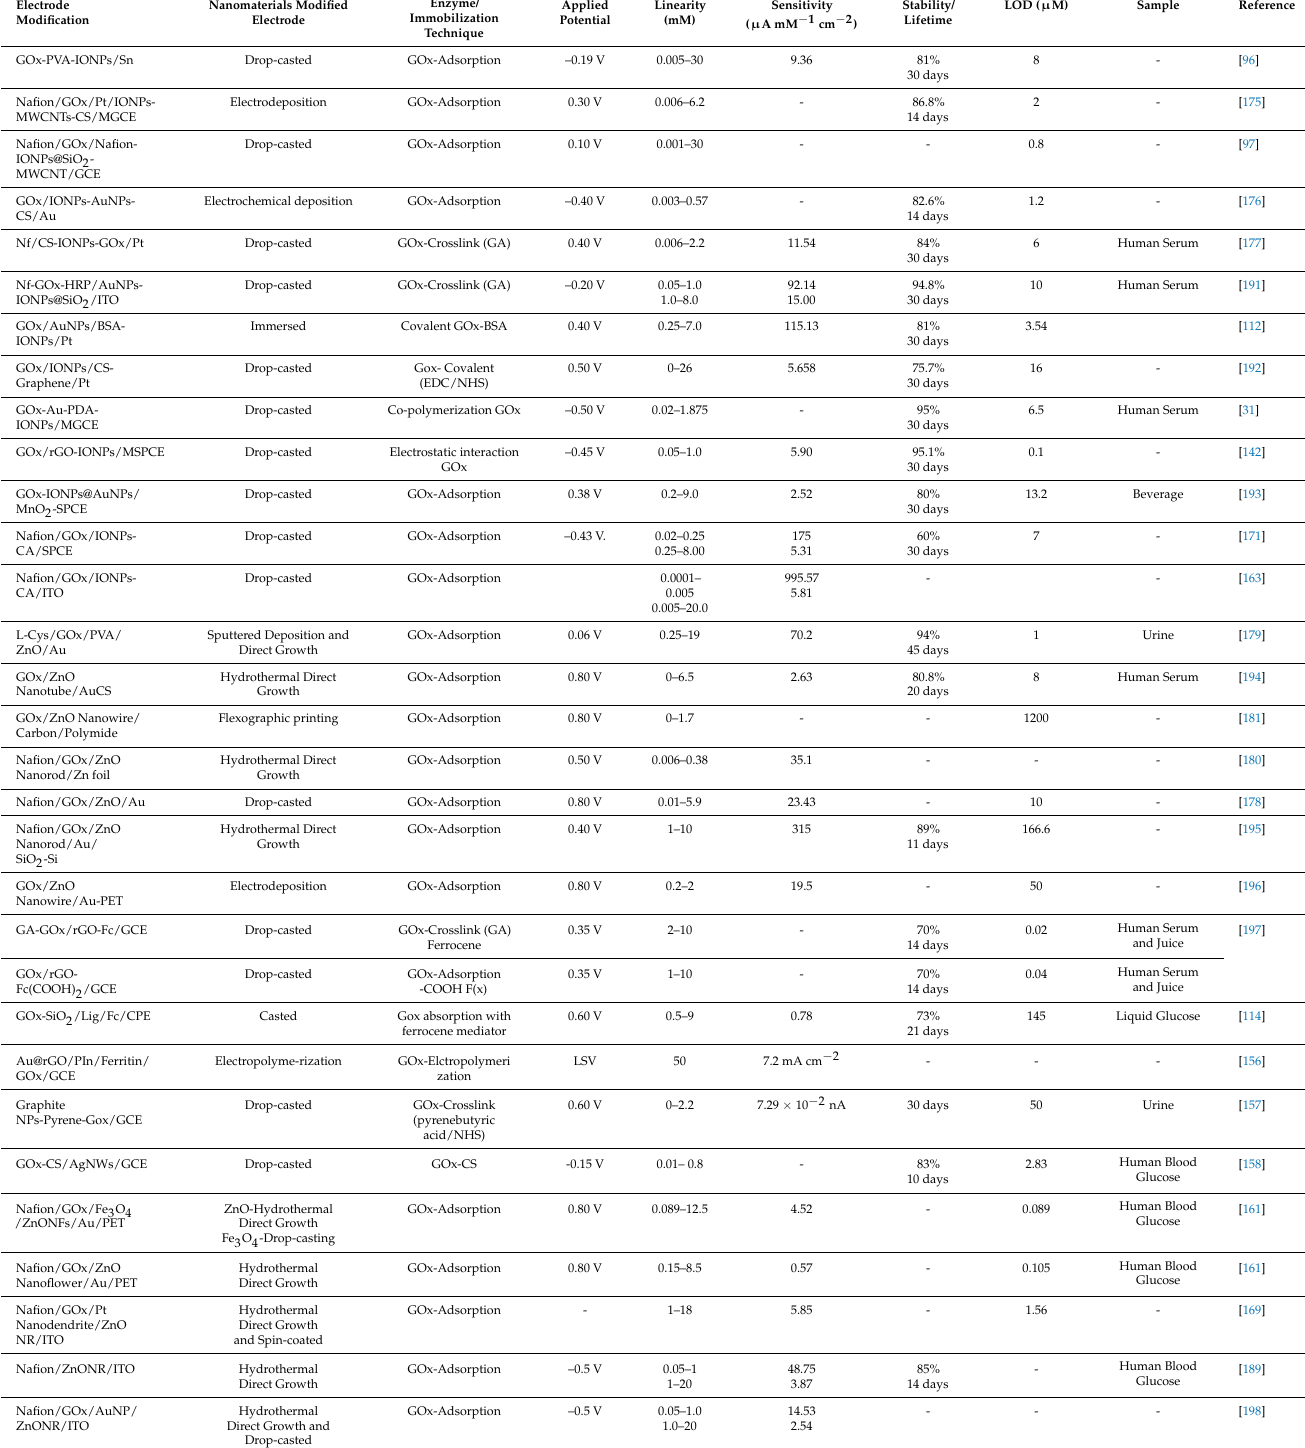
Table 5. Summary of enzymatic glucose biosensors metal oxide-based nanomaterials and nanohy-